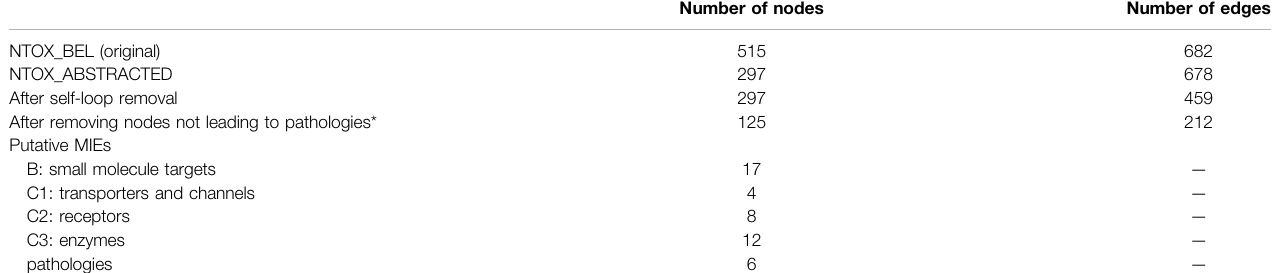
Number of nodes